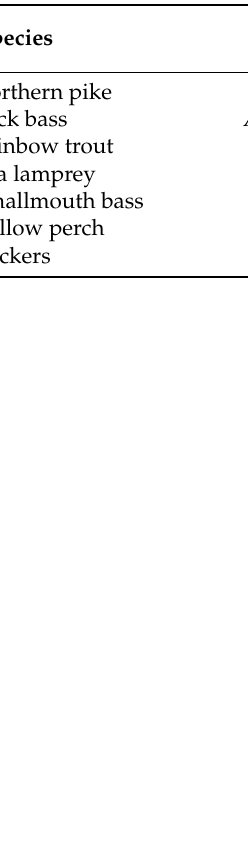
Figure 5. Turbulent kinetic energy contour with velocity vectors measured in front of the ASFL without attraction flow at a depth of ( a ) 30 cm and ( c ) 80 cm and with attraction flow at a depth of ( b ) 30 cm and ( d ) 80 cm. The y–axis origin is the entrance of the ASFL, centered at x = 45 cm. Attraction flow nozzles are located at y = 0, x = 20 and 70 cm. Note, the orientation is the same as Figure 3. Table 2. Total count and average and maximum length of fish transported by the ASFL during the entire test period. Note, only 169 (25%) of the suckers caught were measured for total length.